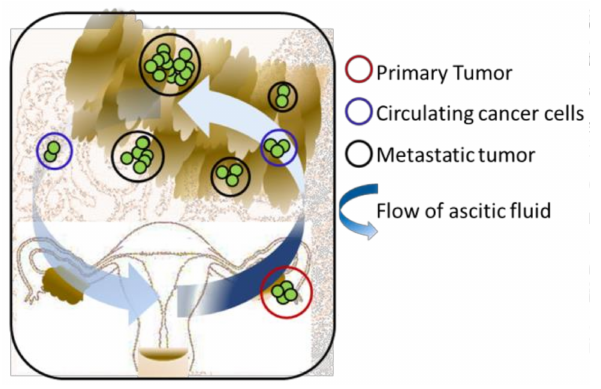
Figure 1. Pathogenesis of the ovarian cancer